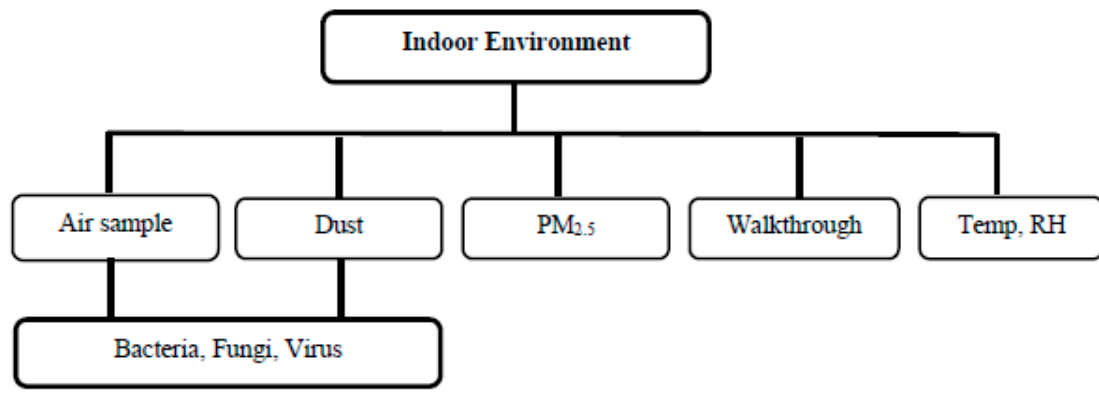
Figure 3. Diagram showing indoor air pollutants that will be assessed in the HAIM project. Temp, Temperature; RH, Relative Humidity.